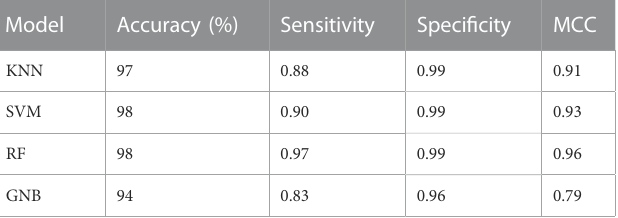
TABLE 2 Overall performance of machine learning models on the train set.